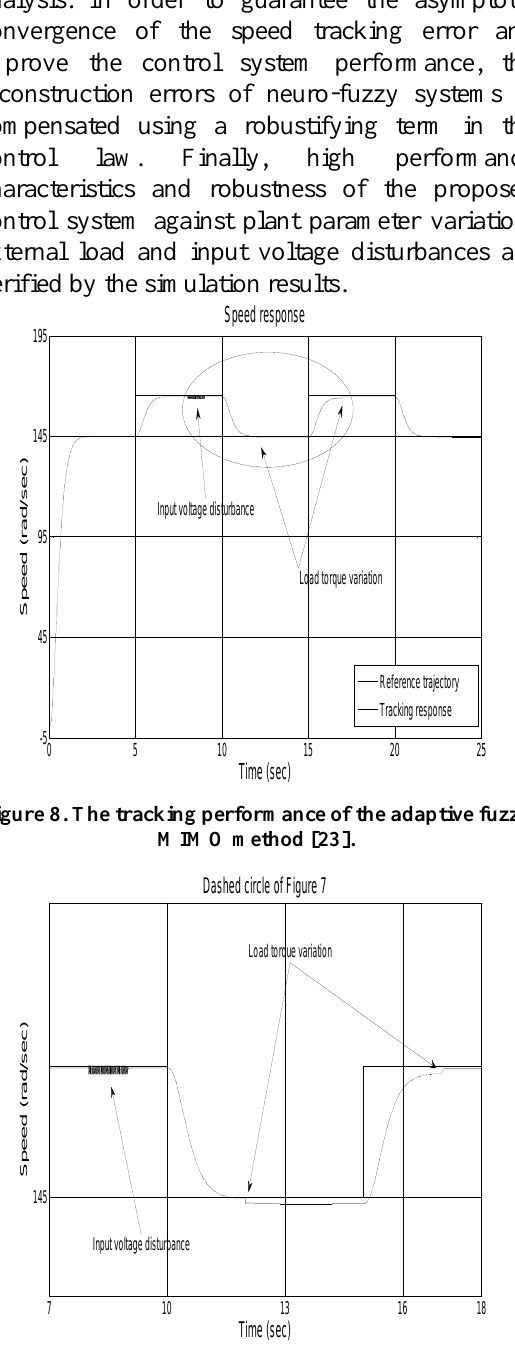
Figure 9. Dashed circle of the Figure 8 is